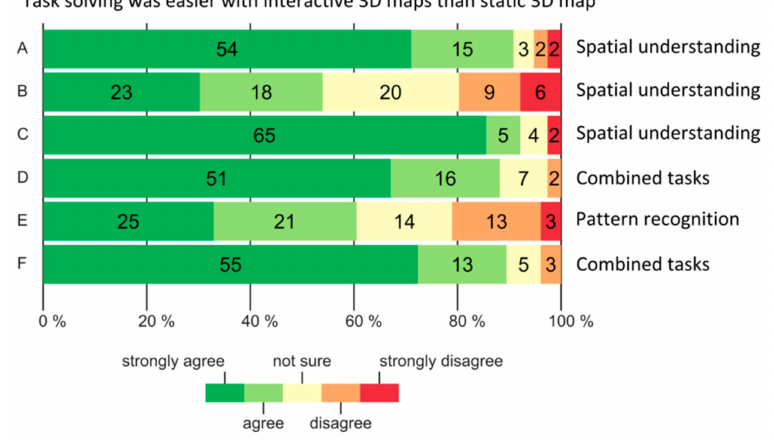
Figure 5. Subjective preferences of interactive 3D maps for individual task